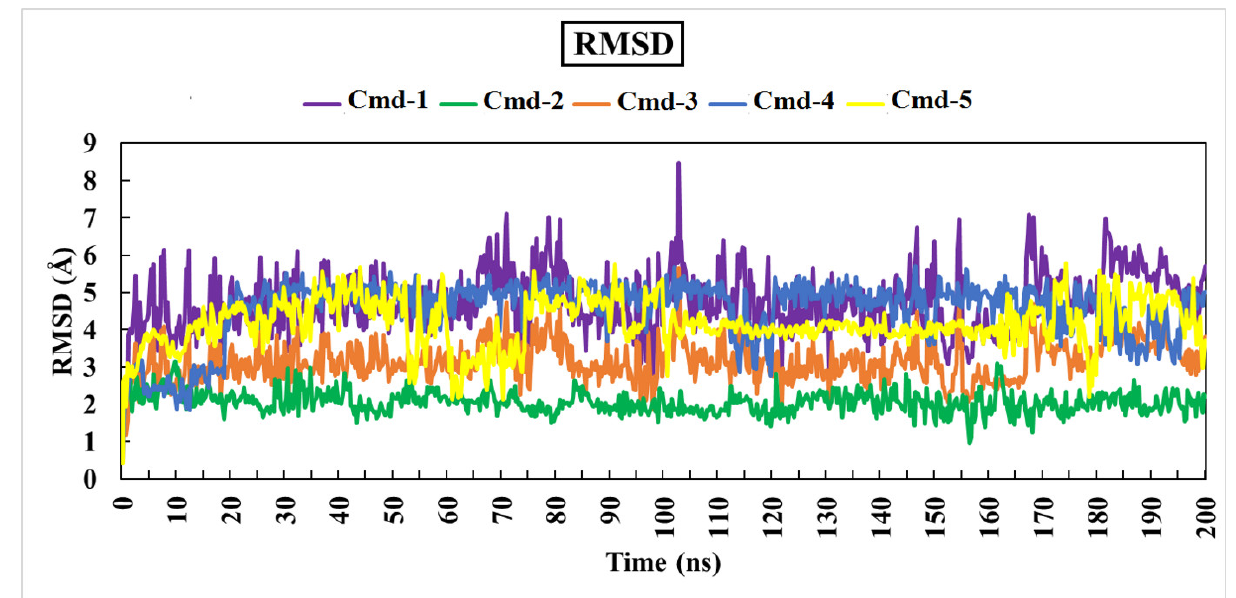
Figure 4. Root-mean-square-deviation (RMSD) of Omicron BA.1 backbone atoms from the initial structure complexed with the highest-ranked Cmds over 200 ns MD simulations.